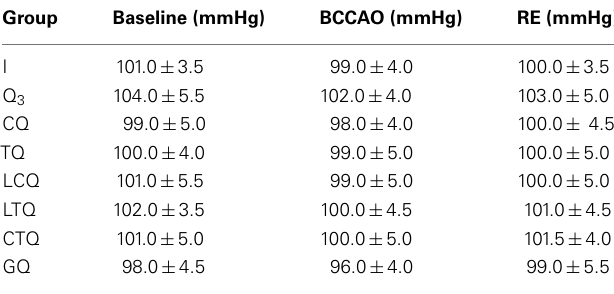
Table 3 | Mean arterial blood pressure (MABP) under baseline conditions, at the end of bilateral common carotid artery occlusion (BCCAO) and at the end of reperfusion (RE) in sham-operated (S) group, ischemic (I) group, quercetin (Q 3 ) group (5mg/Kg b.w.), chelerythrine plus quercetin (CQ) group, tyrphostin 47 plus quercetin (TQ) group, L-NAME and chelerythrine plus quercetin (LCQ) group, L-NAME and tyrphostin 47 plus quercetin (LTQ) group, chelerythrine and tyrphostin 47 plus quercetin (CTQ) group, glibenclamide plus quercetin (GQ)